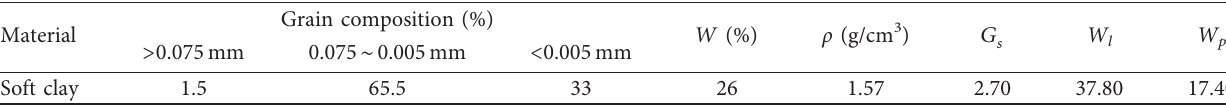
Table 1: Physical properties of the Qingyi River site clay used in this study. Soil tests were conducted in accordance with the Chinese standard SL237-1999.